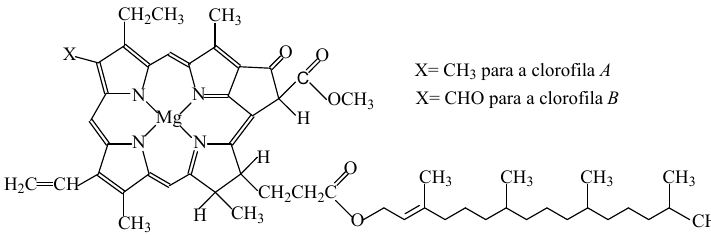
Figure 4. Structural formula of chlorophylls a and b .